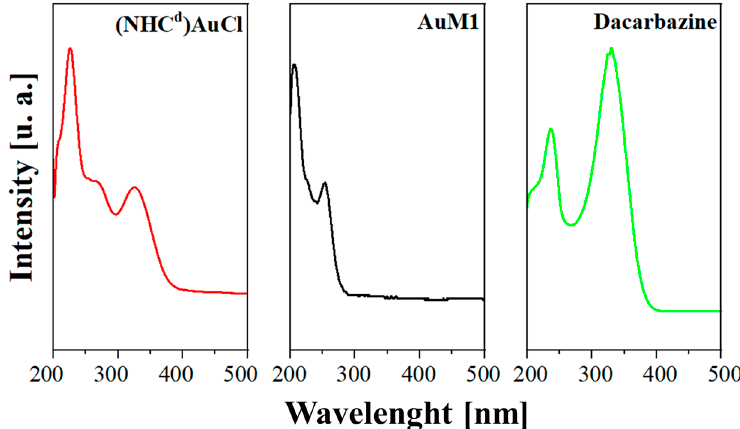
Figure 10. UV-Vis Spectra of Dacarbazine, AuM1 and (NHC d )AuCl. The absorptivities of the active substances are reported in Table 2. Table 6. Absorptivity of the active substances in PBS solution.